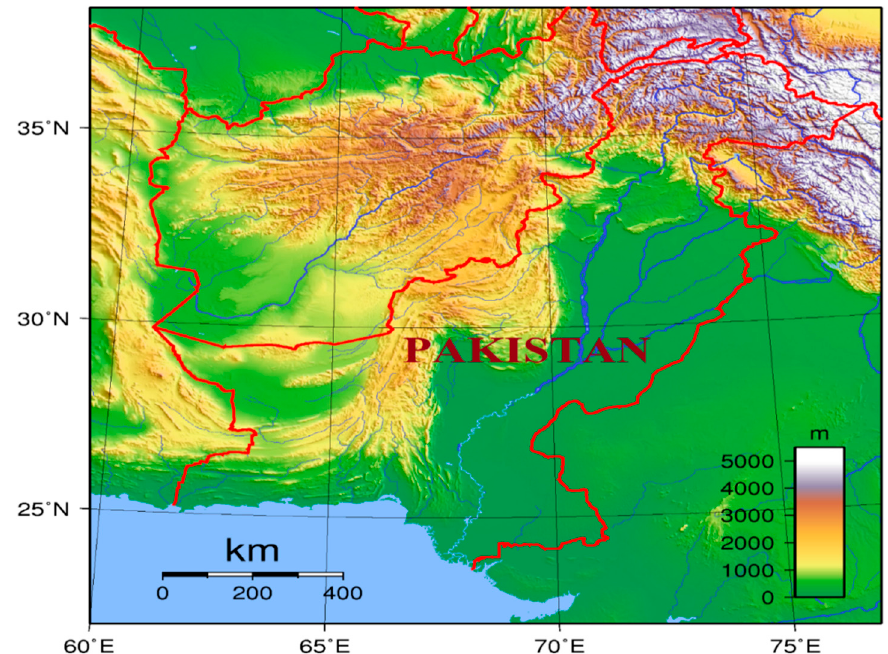
Figure 10. Topographical map of Pakistan.